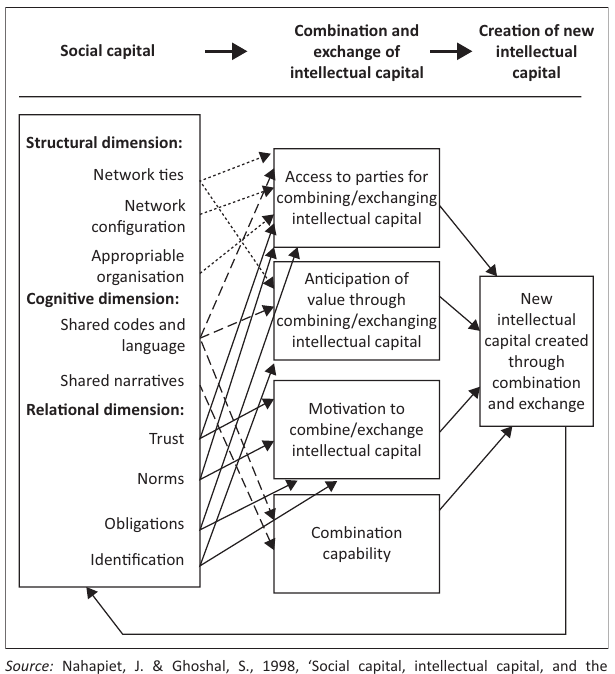
FIGURE 1: Model of social capital in the creation of intellectual